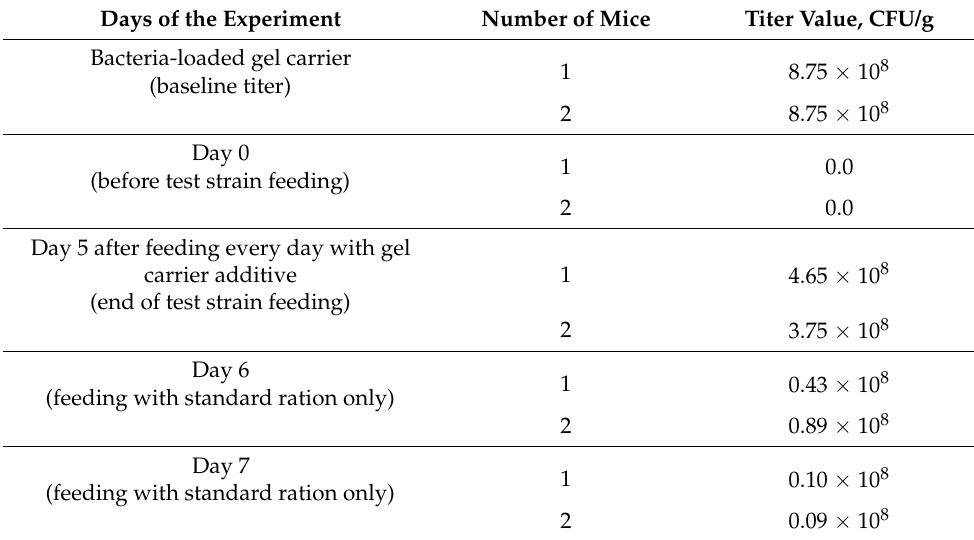
Table 1. Titer of test strain B. subtilis 20 in mice feces after gel carrier’s passage through the gastroin- testinal